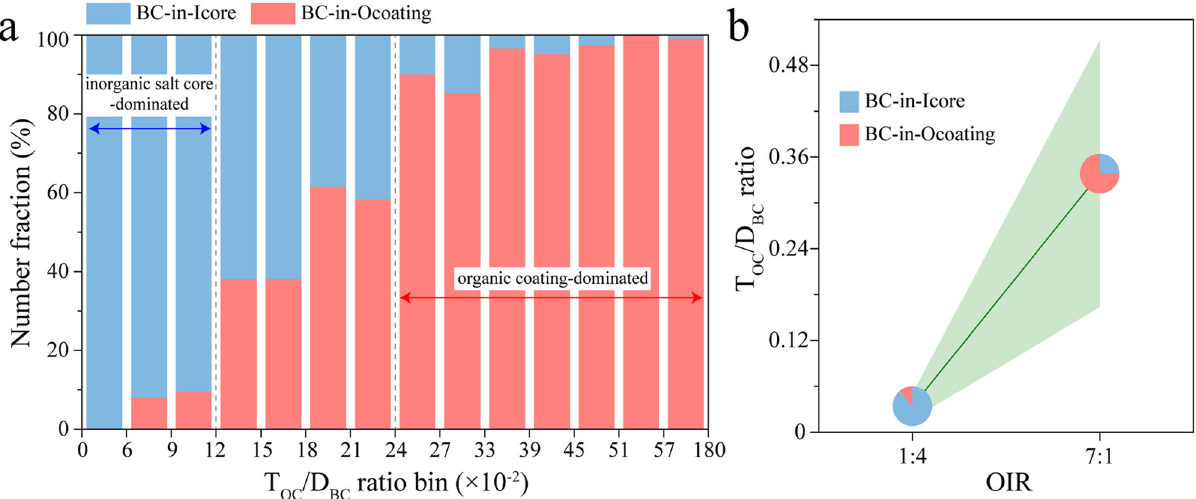
Fig. 4 Distribution of BC inside individual particles depending on the ratio of T OC /D BC . a Variation in the number fractions of fi eld-observed BC-in-Icore and BC-in-Ocoating particles from the T OC /D BC ratio bins of 0 – 1.8. b Comparisons on the BC distribution and the T OC /D BC ratio of organic/inorganic/BC mixed particles generated from the suspensions with organic-to-inorganic dry mass ratio (OIR) = 1:4 and OIR = 7:1 in the laboratory. The green shadow indicates the standard deviation of the T OC /D BC